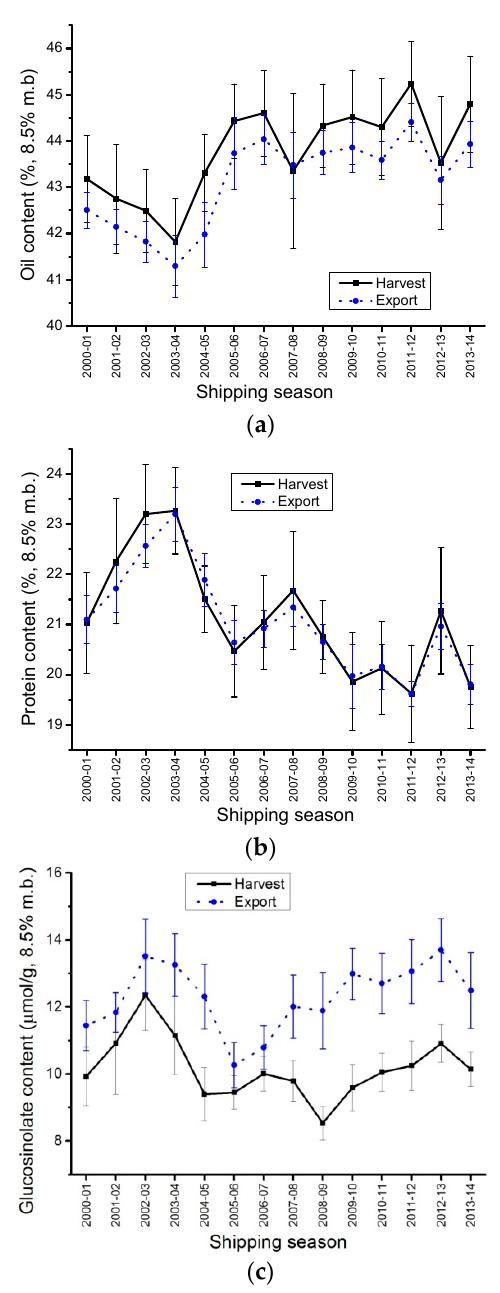
Figure 2. Canola oil, protein and total glucosinolate content averages (at 8.5% moisture basis), harvest (HSD) and export (ECD) samples of Canada No.1, Canola from 1 August 2000 to 31 July 2014. ( a ) Canola oil content averages (%); ( b ) Canola protein content averages (%); ( c ) Total glucosinolate content averages (µmol/g).